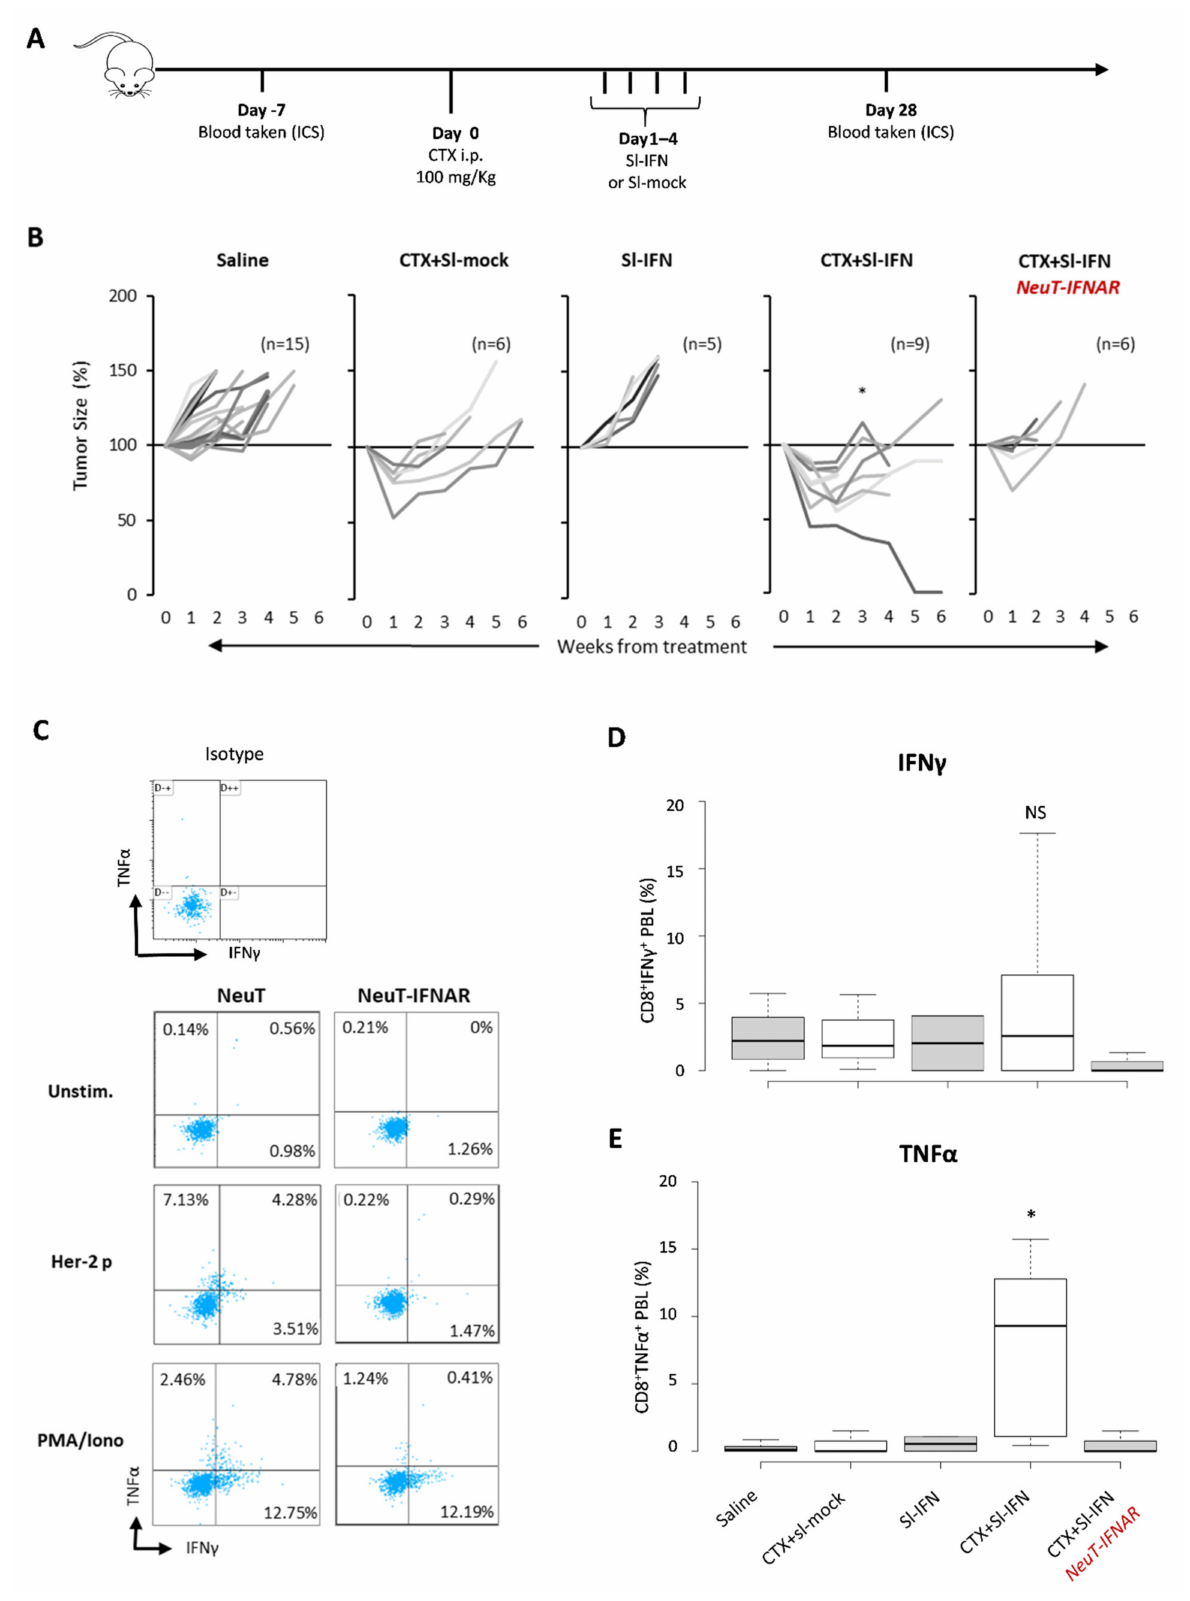
Figure 5. Therapeutic effect of combined CTX/Sl-IFN treatment in NeuT transgenic mice. ( A ) Schematic representation of the experimental design. ( B ) Percentage tumor size in NeuT 129sv mice treated with CTX and Sl-mock ( n = 6) or with